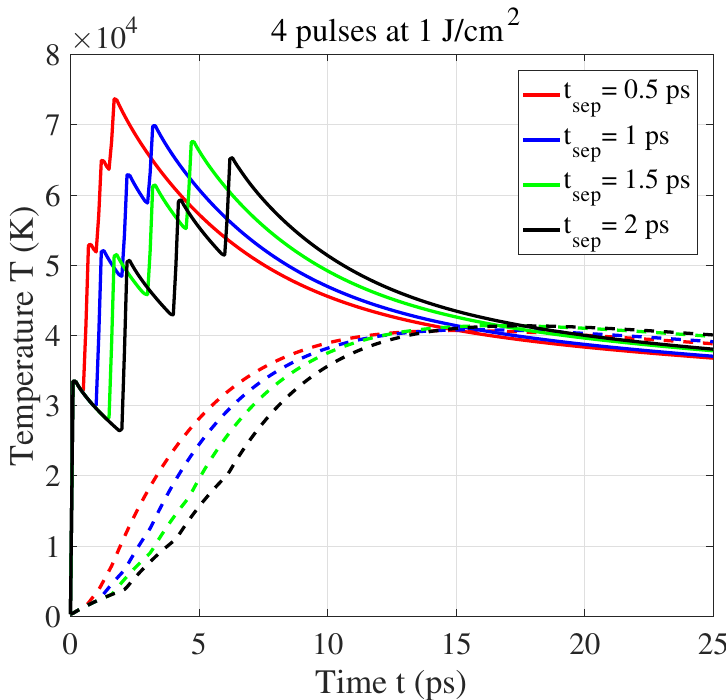
Figure 4. Time dependence of the calculated electron (solid line) and lattice (dash line) temperatures with varying separation time t sep at a fluence of 1 J/cm 2 and four pulses.